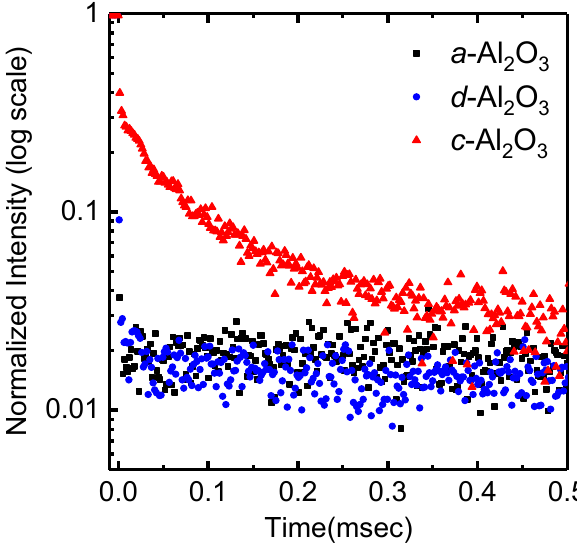
Figure 5. Time-resolved photoluminescence curves for Si-implanted Al 2 O 3. [38] .